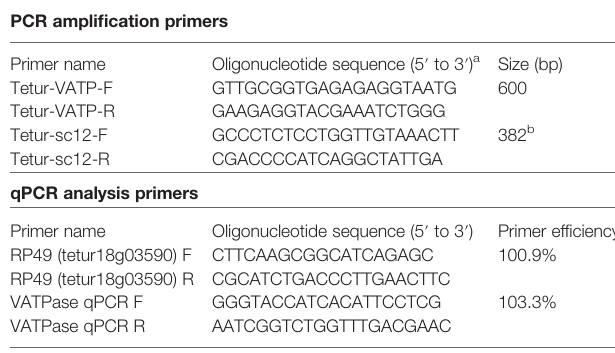
TABLE 1 | Primers used in this study for dsRNA production and real-time qRT- PCR